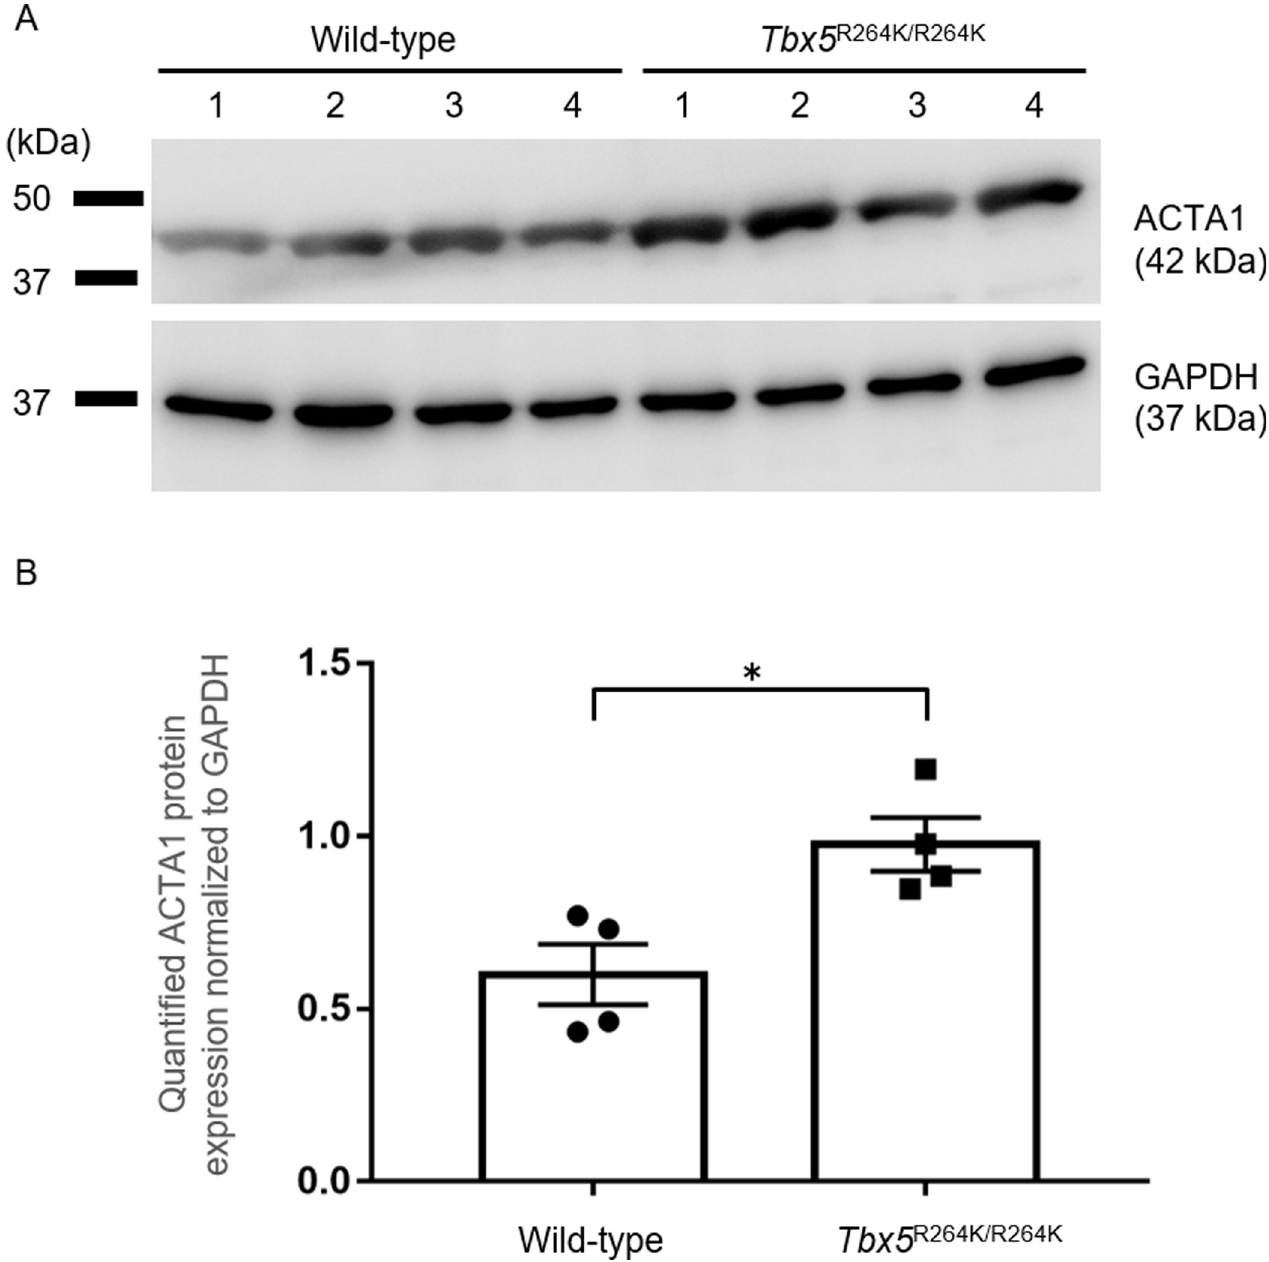
Fig 5. Comparison of ACTA1 protein expression in hearts of young adult Tbx5 R264K/R264K and wild-type mice. A Western blotting shows expression of ACTA1 protein (upper) in young adult Tbx5 R264K/R264K and wild-type mice. GAPDH (lower) is shown as loading controls. The number of samples is four respectively. B In the young adult Tbx5 R264K/R264K mice, the amount of ACTA1, normalized to GAPDH was about 1.6 times higher than that of in the wild-type mice. Quantified ACTA1 value normalized to GAPDH (mean ± SEM) is plotted. P value � < 0.05, versus wild-type.